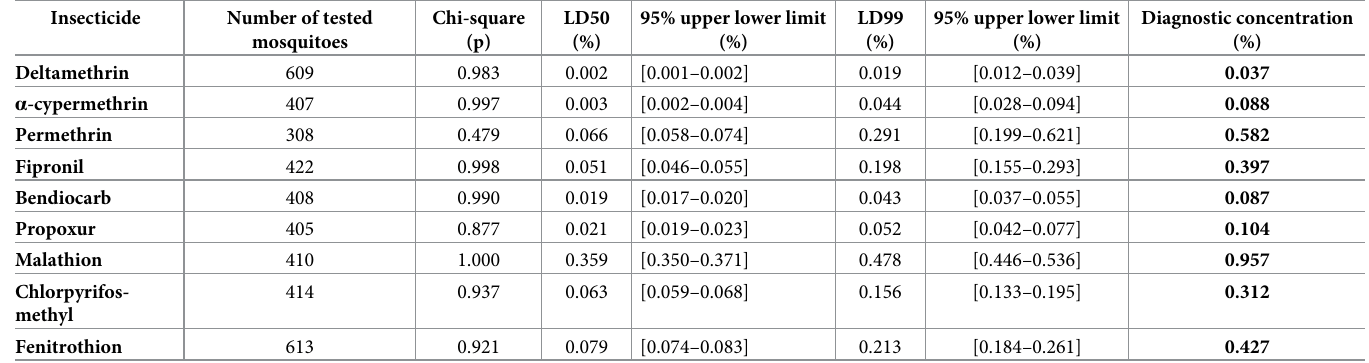
Table 1. Diagnostic concentrations of the reference strain of Aedes aegypti (susceptible strain: New Orleans).